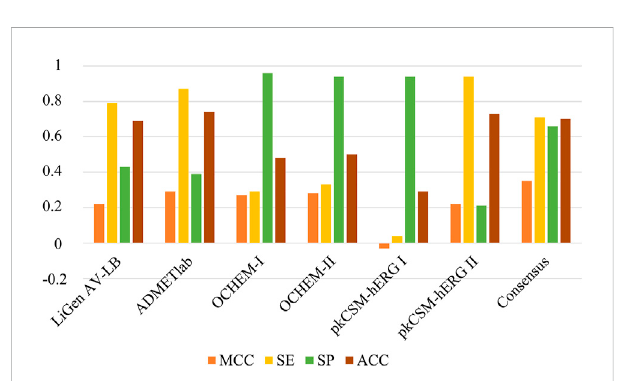
FIGURE 10 Comparison of the performances between LiGen AV-LB model